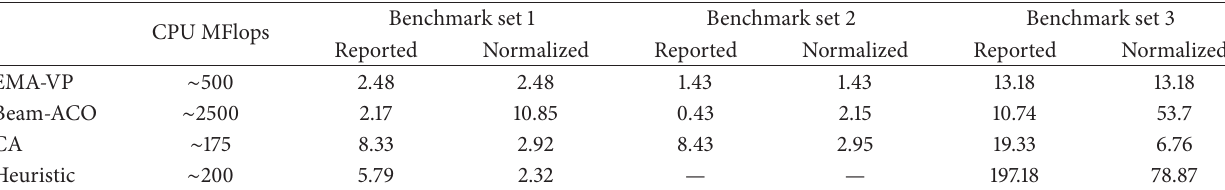
Table 7: Mean CPU time (sec) comparison on the